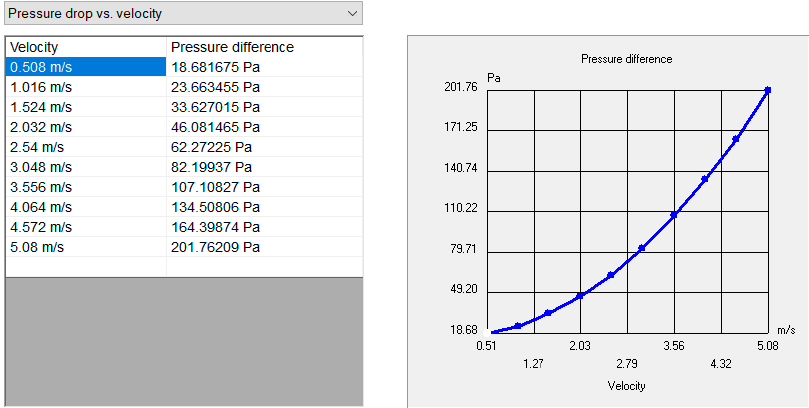
Figure 4. Dependence of pressure difference ∆ P (Pa) on the flow rate of the liquid V (m/s). The calculation of particle motion was considered in a steady flow of a fluid medium. particles of constant mass, the effect of which on the flow is negligible, but the flow affects the speed and temperature (and hence the density) of the particles, which in turn affects their size.